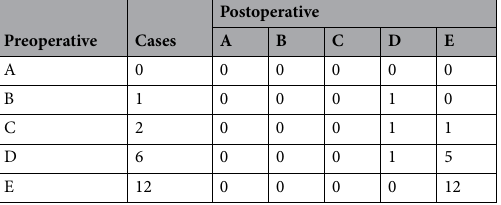
Table 5. Neurological functional recovery according to the ASIA